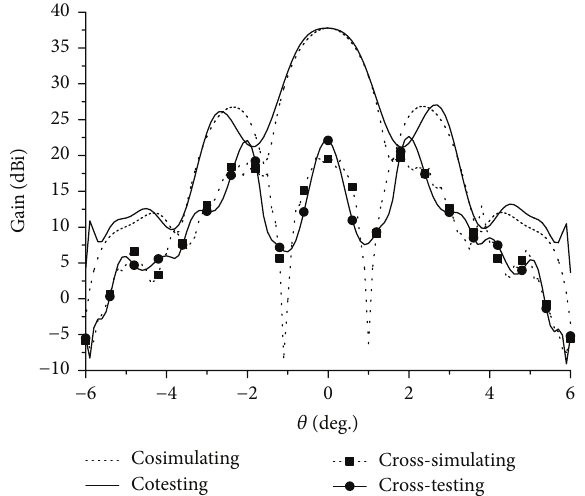
Figure10:Simulatingandtestingradiationpatternin 𝜑 = 90 ∘ plane.